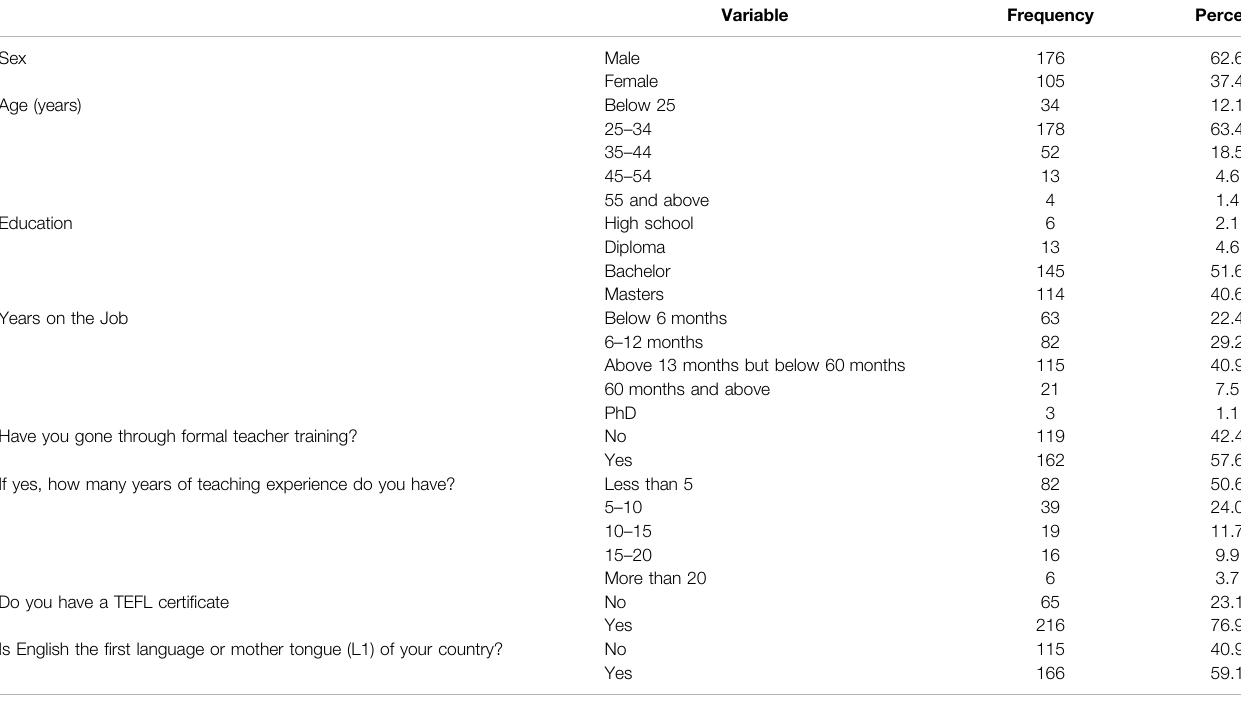
TABLE 2 | Background information of respondents.